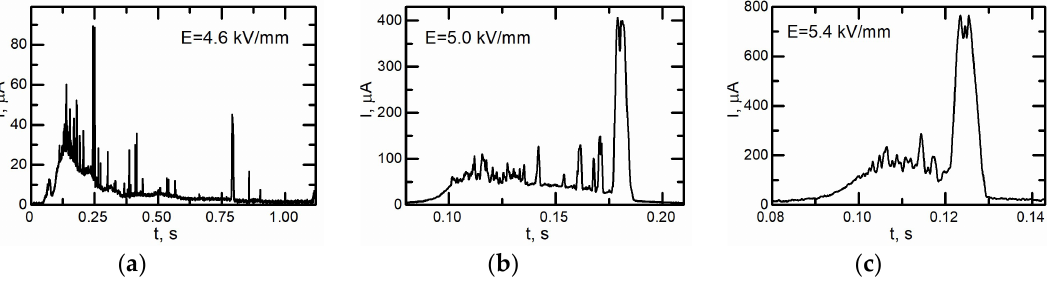
Figure 1. Typical switching current shapes measured during the polarization reversal without artificial dielectric layer. Field: ( a ) 4.6 kV/mm; ( b ) 5.0 kV/mm; and ( c ) 5.4 kV/mm.